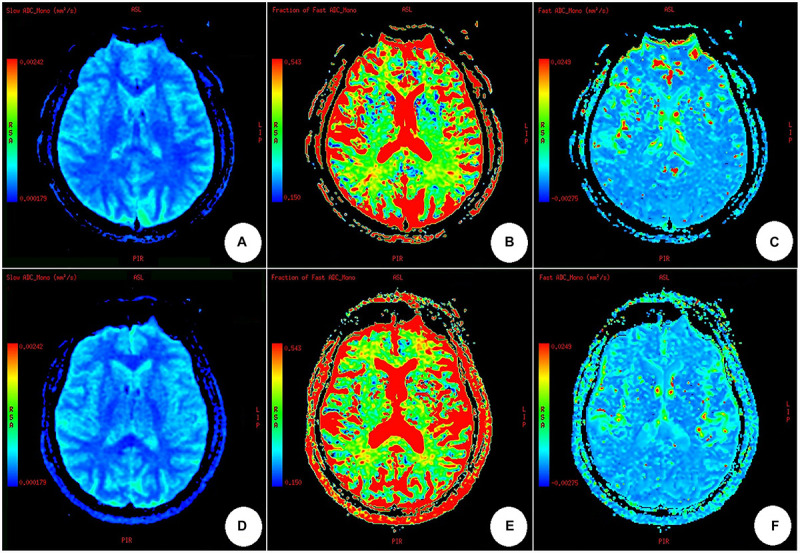
Maps of slow ADC (Ds), fraction of fast ADC (f), and fast ADC (Df) through IVIM fitting. (A–C) A healthy participant; (D–F) a participant with carotid vulnerable plaques. There was no difference among the IVIM parameters obtained from a healthy subject (A–C) and a participant with carotid artery plaques (D–F), nor was there any difference between the bilateral cerebral hemispheres in (A–F), by naked eye observation.